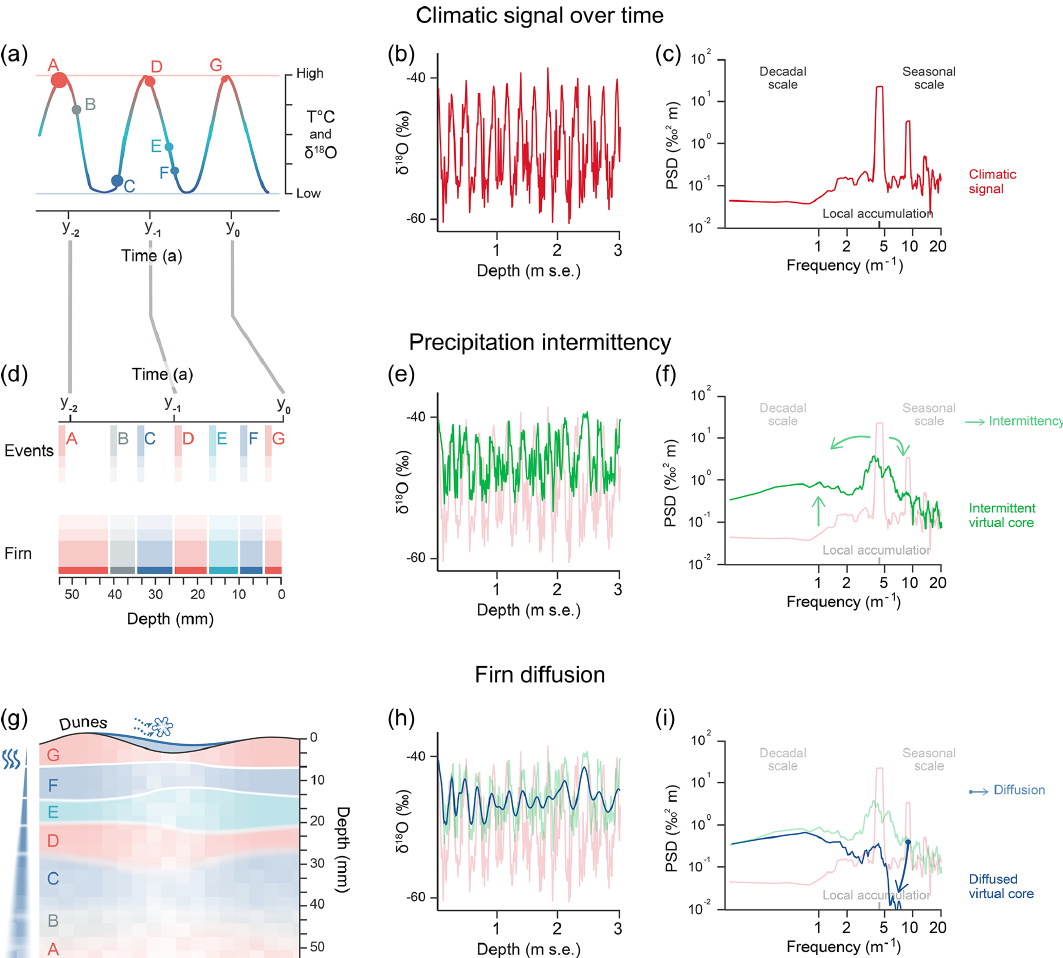
Figure 2. Description of the archival processes included in the forward model that lead to a loss of signal in the snow isotopic composition. Examples are for EDML: (a) idealized temperature time series with rare precipitation events (capital letters A to G); (b) climatic virtual core: actual temperature time series converted to an isotopic profile for the case of constant daily precipitation; (c) power spectral density of the climatic virtual core in panel (b) ; (d) schematic illustrating the impact of precipitation intermittency on the layering of the isotopic profiles; (e) intermittent virtual core: isotopic composition after precipitation intermittency has affected the signal; (f) power spectral density of the intermittent virtual core in panel (e) ; (g) schematic illustrating the impact of snow redistribution and isotopic diffusion on the snow layering; (h) diffused virtual core: isotopic composition after precipitation intermittency and diffusion have impacted the signal, (i) power spectral density of the diffused virtual core in panel (h) . Note that the depths are expressed in metres of snow equivalent (m